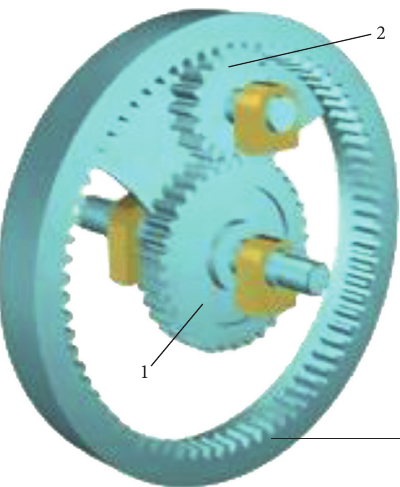
Figure 6: Three-dimensional model of the planetary gear